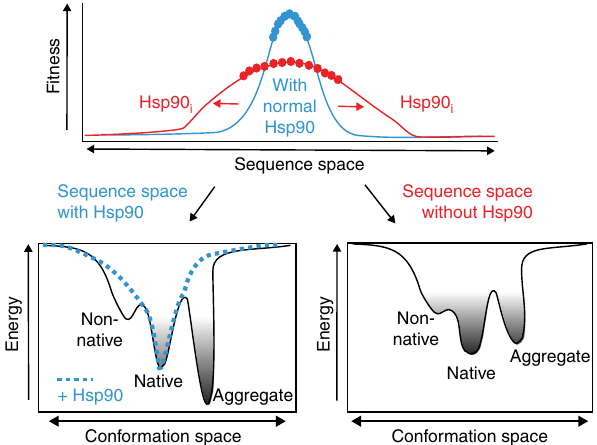
Fig. 6 Hsp90 modulates the energy landscape of its client protein. Role of Hsp90 in shaping protein evolution by modulating the energy landscape of protein folding and balancing trade-offs between protein stability, aggregation propensity, and folding. Hsp90 allows exploration of variants that increase aggregation propensity and hydrophobicity, which may also lead to increased protein stability. Under reduced Hsp90 conditions, the viral sequence space expands to explore variants that reduce aggregation propensity at the expense of stability. See text for